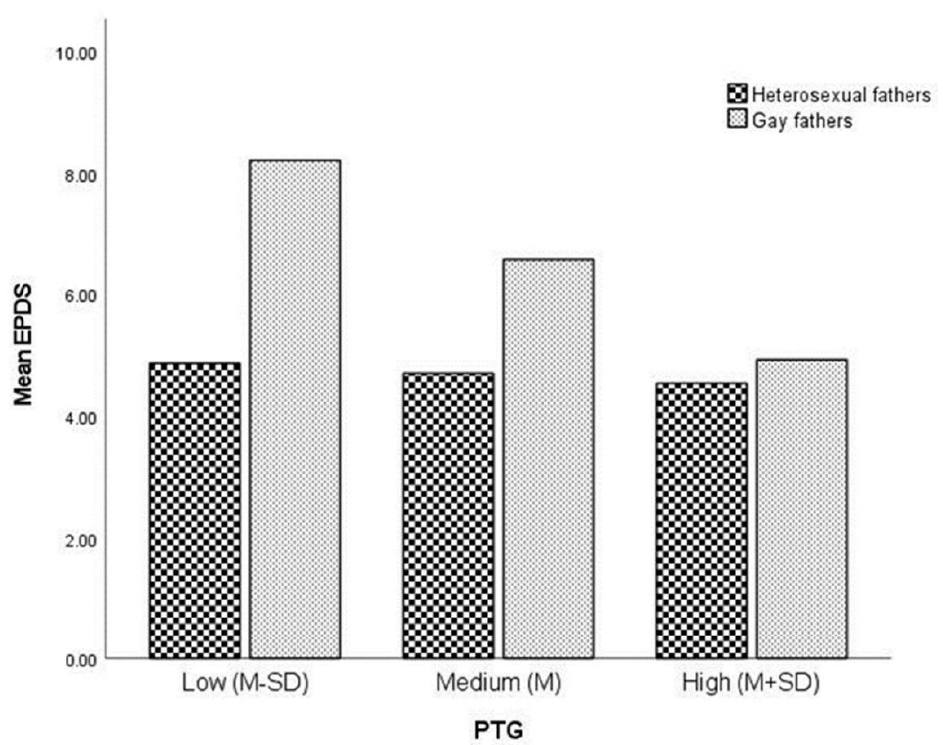
Figure 1. Group by posttraumatic growth (PTGI) interaction affecting Edinburgh Postnatal Depression Scale (EPDS). Simple effects were evaluated at PTGI = 2.80 (low), 3.70 (medium), and 4.60 (high). Table 4. Regression analysis for testing the moderating effect of satisfaction with life on group differences in postnatal depressive symptomatology.